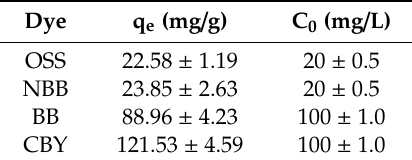
Table2. PreliminarysorptiontestsatpH 7.6startingfromsolutionsatdi ff erentdyes’concentrations(C 0 ).